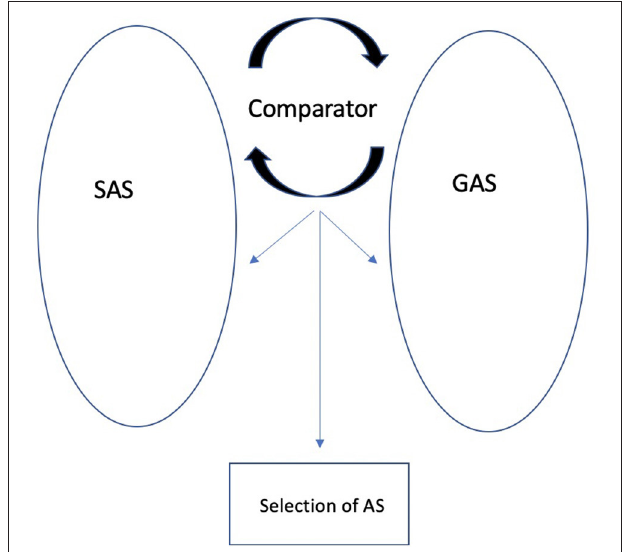
FIGURE 1 | The original REF-model (re-drawn from Mogensen and Malá, 2009).